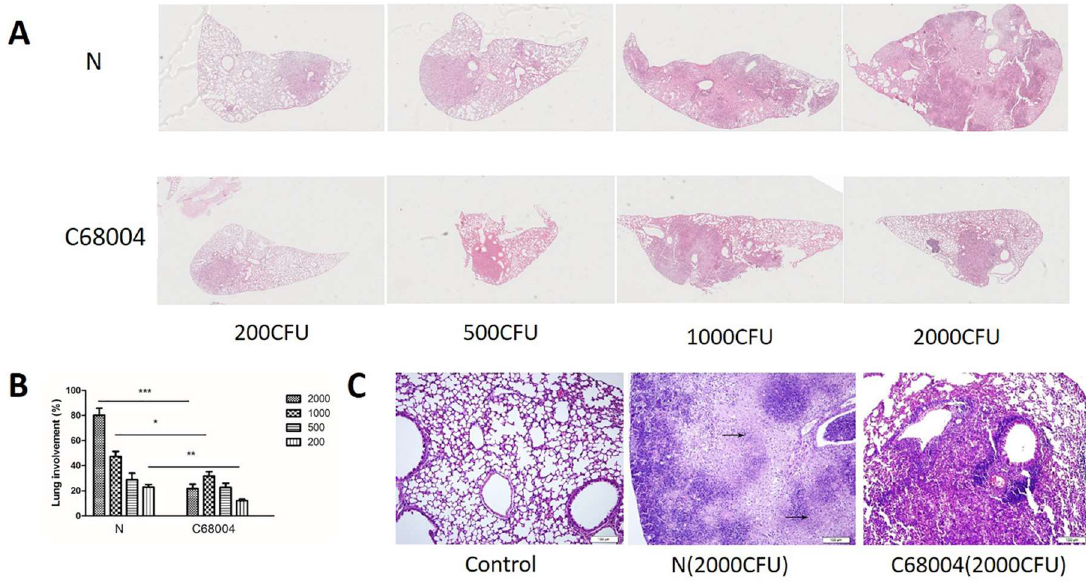
Figure 4 . Development of lung lesions in mice infected with M. bovis N and M. bovis C68004 strains. The lung and spleen were aseptically removed from the mice at the end of the clinical observation (30 days post-inoculation) before death. ( A ) The whole-slide digital images of H&E - stained lung sections. Pictures of the lung of mice infected with 200, 500, 1000, and 2000 CFU of the both strains are shown individually. ( B ) Morphometric analysis demonstrated affected lungs in mice treated with the both M. bovis strains. Results are represented as percentage of lung surface area involved, calculated using ImageJ viewer software (obtained from six animals per group). ( C ) Granulomatous lesions in lung infected with 2000 CFU of the both strains. Pictures of the lung of mice infected with 2000 CFU of M. bovis N and M. bovis C68004 strains and uninfected control are shown individually. The arrows indicate multiple necrotic areas in the lung of mice infected with 2000 CFU of M. bovis N (arrows: necrosis). Scale bar: 100 µ m. * p < 0.05, ** p < 0.01; *** p < 0.001.